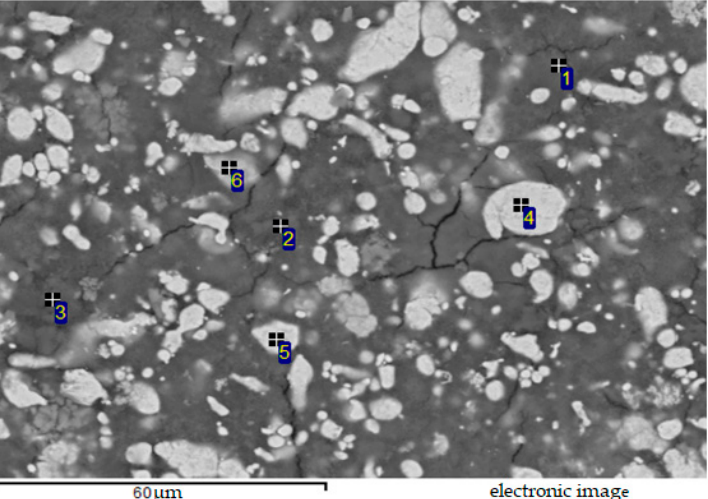
Figure 5. The results of electron microscopic study of the sediment. Magni fi cation by 60 µm. Table 9. Elemental composition of the